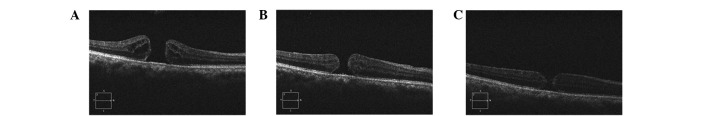
Serial OCT scans showing a patient with a stage IV macular hole. (A) Preoperative OCT line scan demonstrates a full-thickness macular hole with cystic changes. (B) 2 DD of the ILM centered on the macular hole was peeled in the first PPV and the macular hole was not closed. (C) ILM peeling for the secondary surgery was enlarged to the vascular arcades of the posterior fundus and the macular hole did not close but became flat with the cystic changes resolved. OCT, optical coherence tomography; DD, disc diameter; ILM internal limiting membrane; PPV, pars plana vitrectomy.